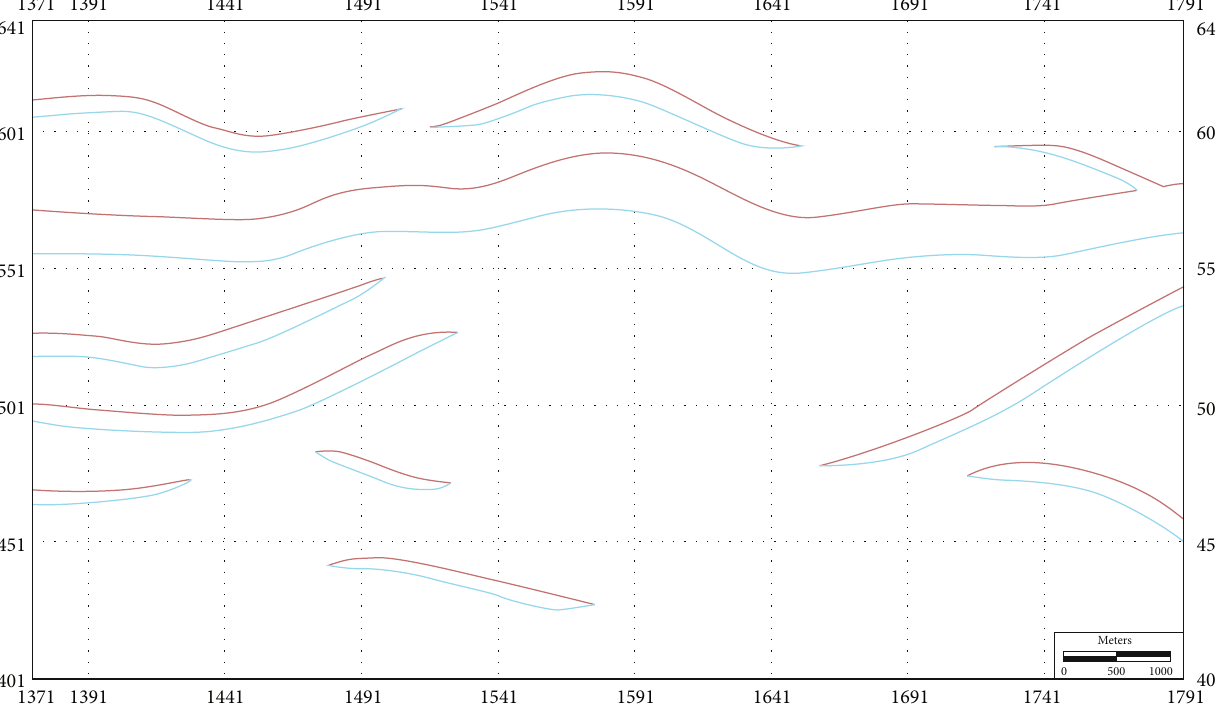
Figure 5: T2 re fl ector plane fracture